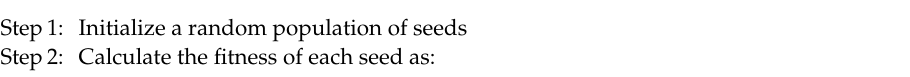
Algorithm 1. Paddy Field